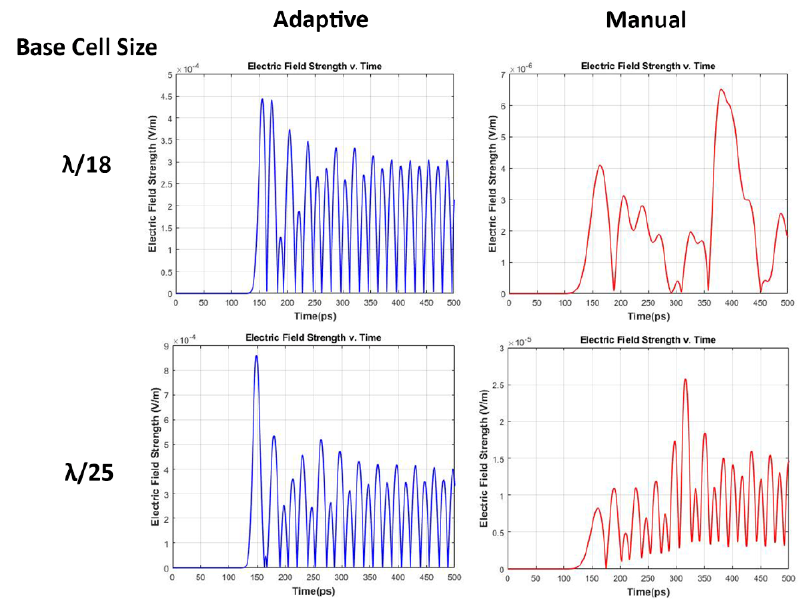
Figure 9. The output from the point sensor at the surface of the cornea. By using adaptive cell size specification, the initial peak of the E-field strength is within the same range using different cell sizes ( λ /18 top and λ /25